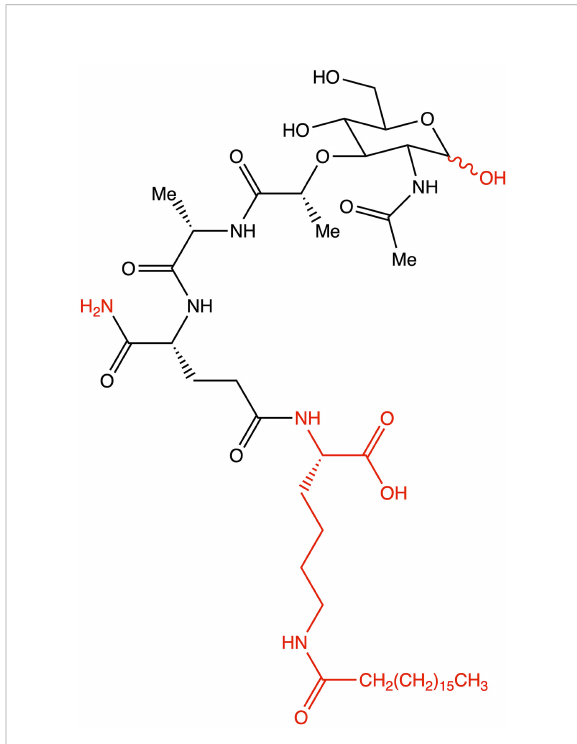
FIGURE 4 Structure of romurtide with indication of structural differences from the starting MDP molecule (red